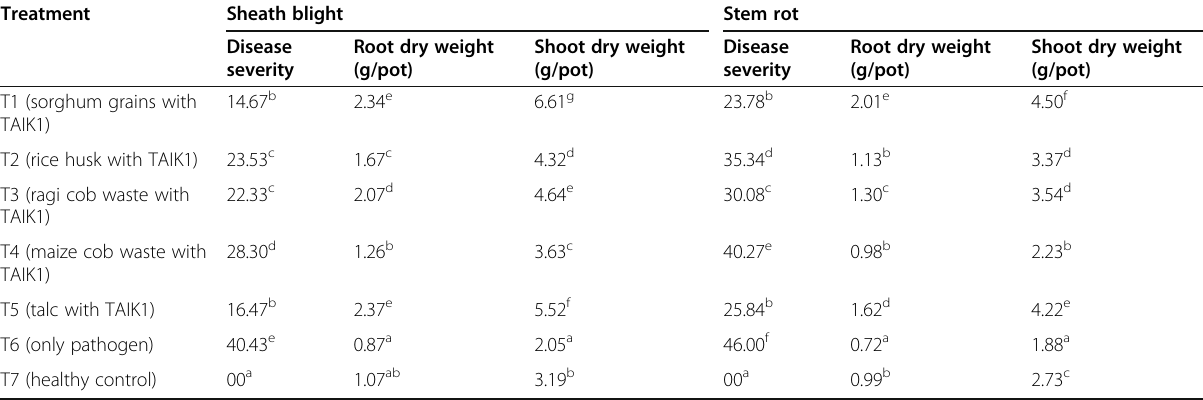
Data represents the mean of three replications. Numerical values with different letters are significantly different ( P < 0.05, DMRT,